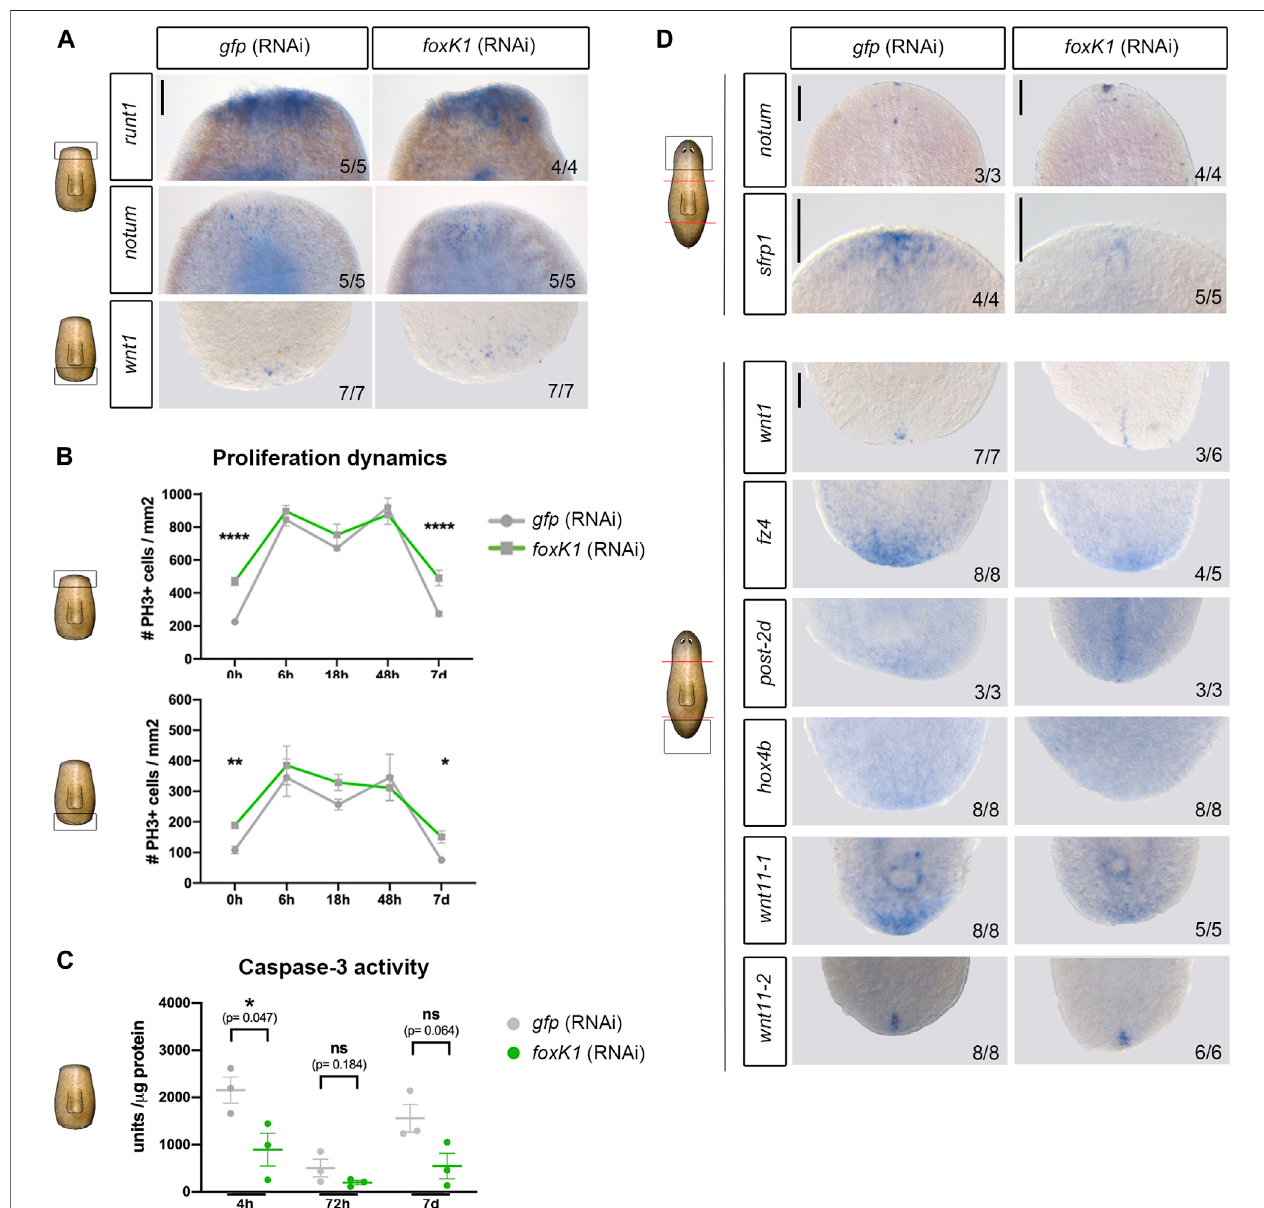
FIGURE 4 | Apoptotic response is affected in foxK1 RNAi animals, but the polarity establishment and proliferative response occurs normally. (A) Whole- mount in situ hybridization analysis of the expression of the early wound response genes in controls and foxK1 RNAi animals 6 h post amputation ( runt1 and notum ) and 12 h post amputation ( wnt1 ). From top to bottom: runt1 in anterior wounds, notum in anterior wounds and wnt1 in posterior wounds. Scale bar: 100 µm. (B) Quanti fi cation of mitotic PH3 + immunolabeled cells after silencing foxK1 at several time points after anterior-posterior amputation. h, hours; d, days (* p -value < 0.05; ** p -value < 0.01 **** p -value < 0.0001. Student ’ s t -test). Values represent the mean ± standard error of the mean [s.e.m] of a mean of at least 4 samples per time point and condition. (C) Quanti fi cation of caspase-3 activity after silencing foxK1 at several time points after anterior-posterior amputation. h, hours; d, days (* p -value < 0.05; Student ’ s t -test). Values represent the mean ± standard error of the mean [s.e.m] of a mean of 3 biological samples per time point and condition. (D) Whole-mount in situ hybridization analysis of the expression of the genes responsible for establishing the anterior and posterior identity in controls and foxK1 RNAi animals 3 days post amputation (notum, wnt1, frz4, post2d and hox4b ), 6 days post amputation ( wnt11_1 and wnt11_2 ) and 7 days post amputation ( sfrp1 ). Anterior polarity genes (from top to bottom): notum and srfp1 . Posterior polarity genes (from top to bottom): wnt1, frz4, post-2d, hox4b, wnt11-1 and wnt11-2 . Scale bar: 100 µm. In the schematic planarians, red lines indicate the amputation planes and black squares the region analysed.